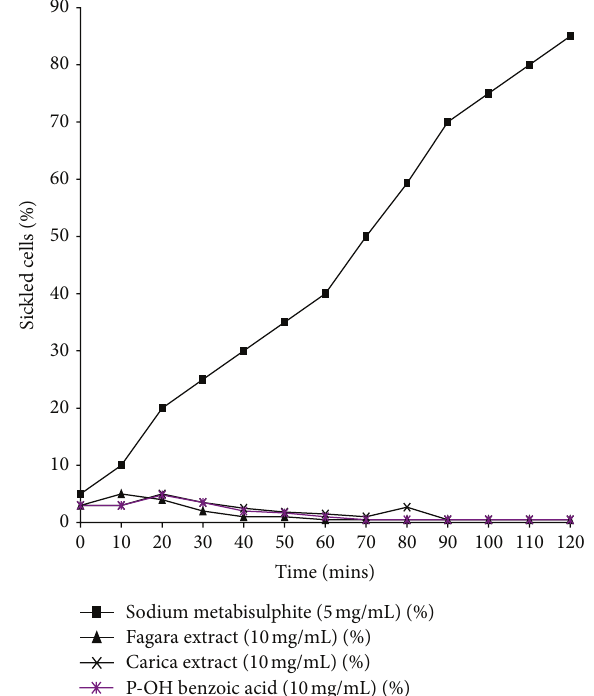
Figure 8: Time course of phytomedicines on